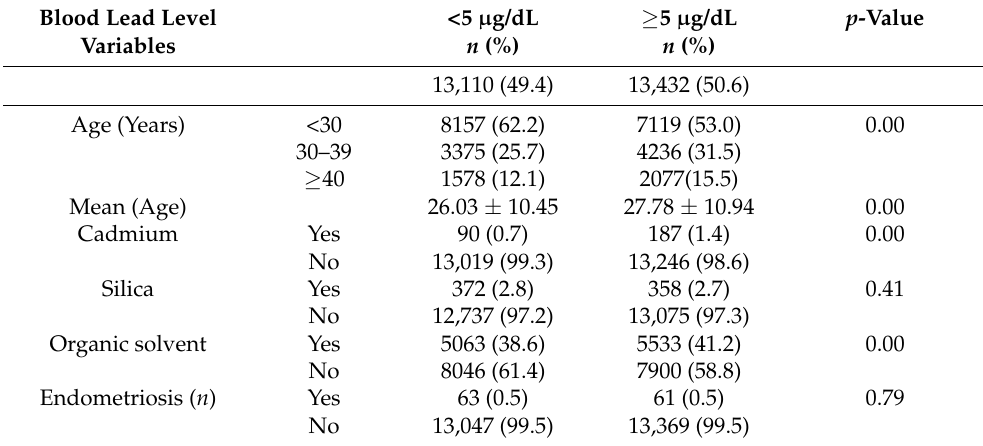
Table 1. Age, Tenure, Cadmium, Silica, and Organic Solvents Exposure by BLLs in Lead Exposed Female Workers.